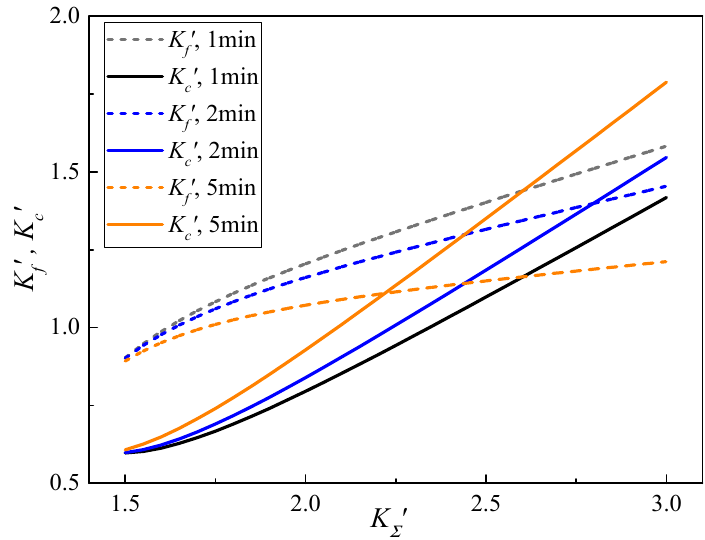
Figure 9. Springback and residual relative curvature equation curve.